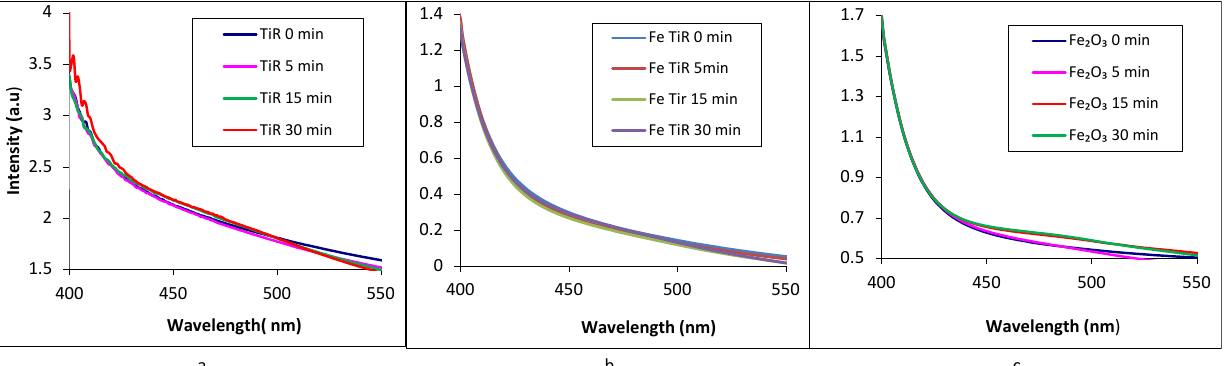
Figure 6. Investigation of O 2 − generation over TiR ( a ), FeTiR ( b ), Fe 2 O 3 cubes ( c ) under simulated solar light irradiation.